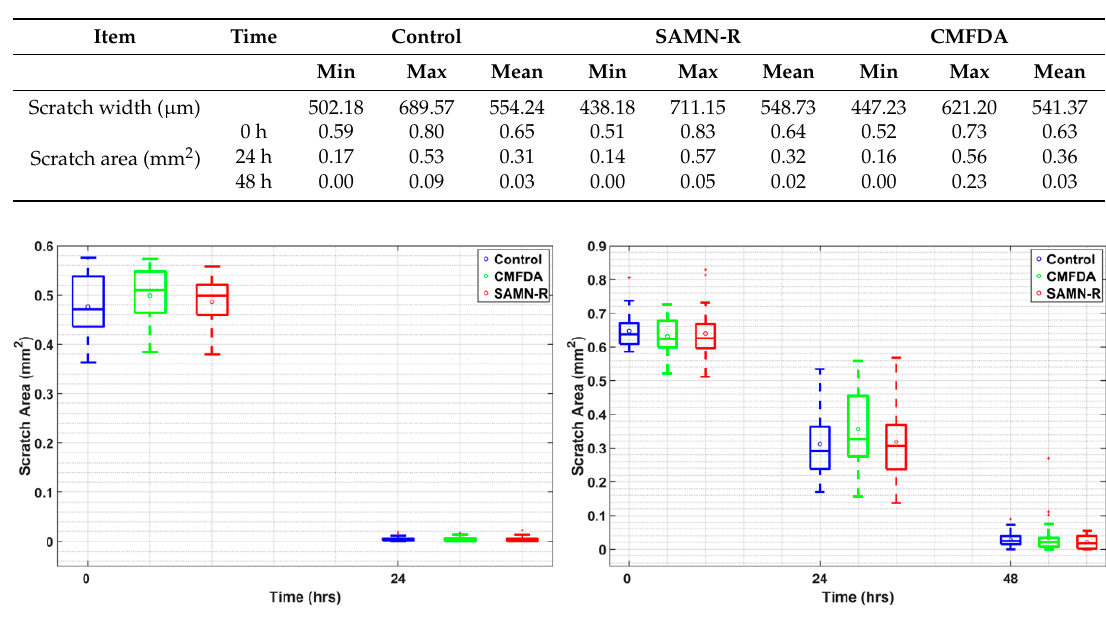
Table 2. Size values of the open area of wide scratch in the wound healing assay experiment.